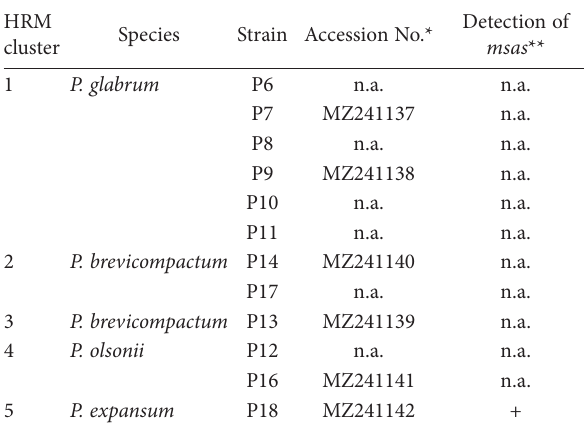
Figure 4. Phylogenetic tree for Aspergillus strains based on a por- tion of the calmodulin gene. Numbers on nodes represent the Maximum Likelihood bootstrap percentages. Branch lengths are proportional to the numbers of nucleotide substitutions and can be measured using the bar scale (0.05). Table 5. Penicillium HRM clusters, species, strains, GenBank acces- sion numbers for the β-tubulin gene, and presence of a patulin bio- synthetic gene ( msas ).